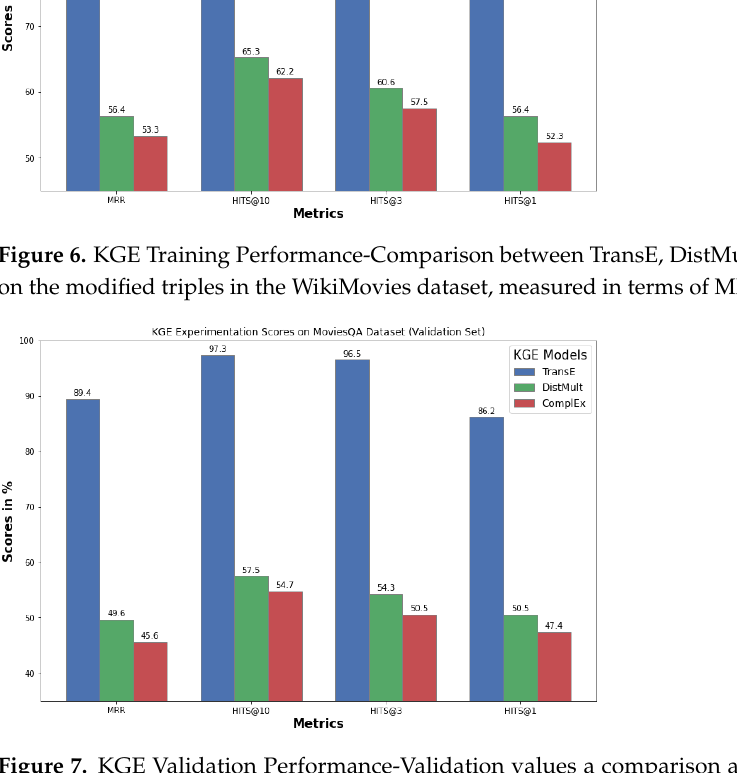
Figure 7. KGE Validation Performance-Validation values a comparison among TransE, DistMult, and CompEx models on the modified triples on the WikiMovies dataset, measured in terms of MRR and